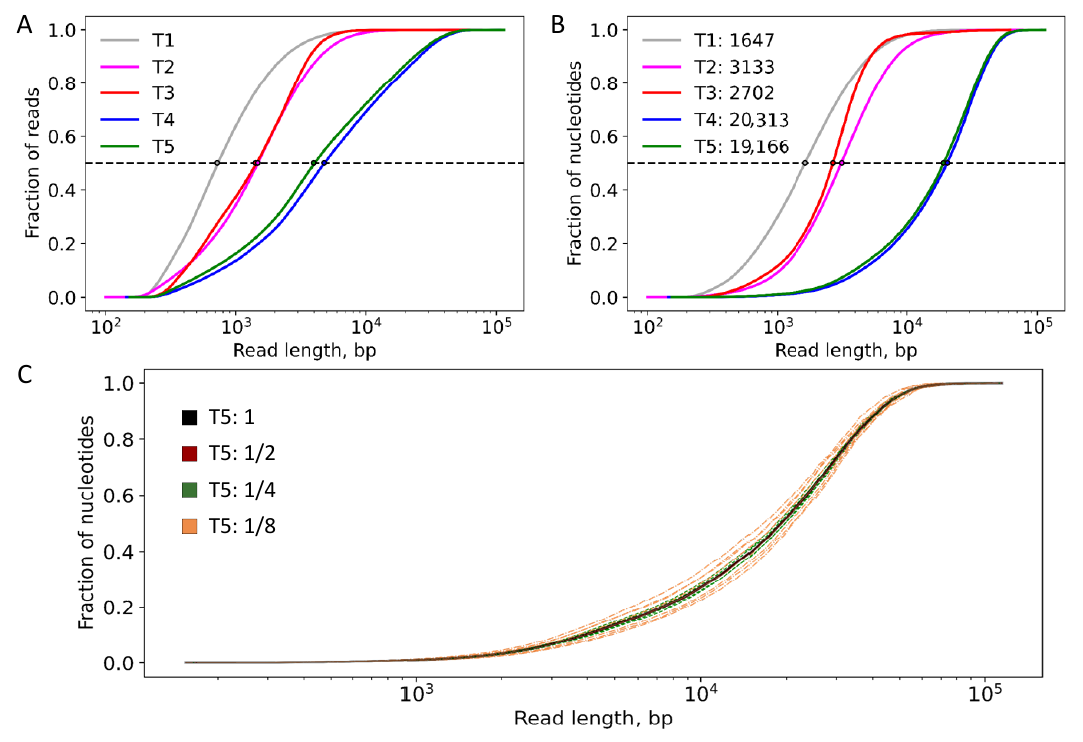
Figure 1. Accumulation curves demonstrating read length distributions for considered samples. ( A , B ) Entire samples T1 – T5. Each point on the curve corresponds to the fraction of all ( A ) reads or ( B ) nucleotides, with the read length equal to or smaller than the read length at this point. In the legend of panel ( B ), the values after colons are the lengths of reads at which the curves reach the fraction value of 0.5. ( C ) The same graph as ( B ) obtained for the T5 set and its subsets, values after colons are the fractions of reads from the entire set of T5 sample in the corresponding curves.